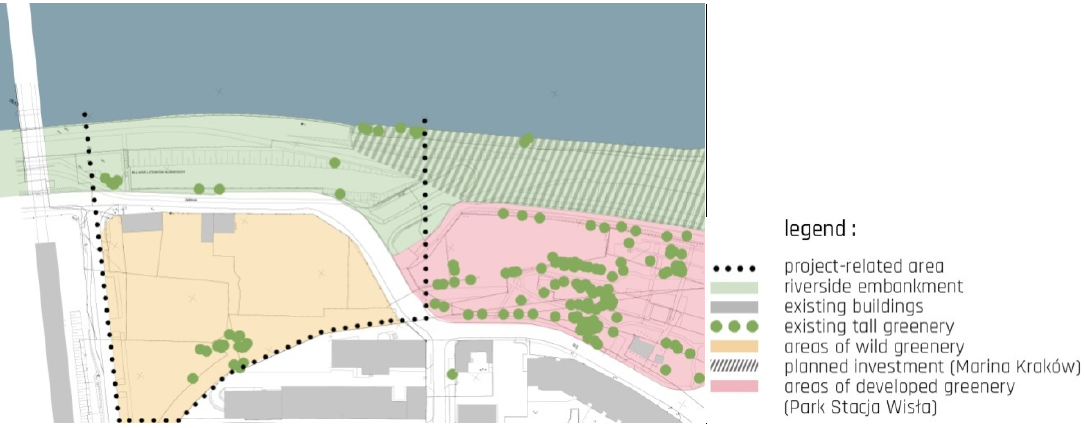
Figure 19. Analysis of greenery, (elaborated by E. Latusek).